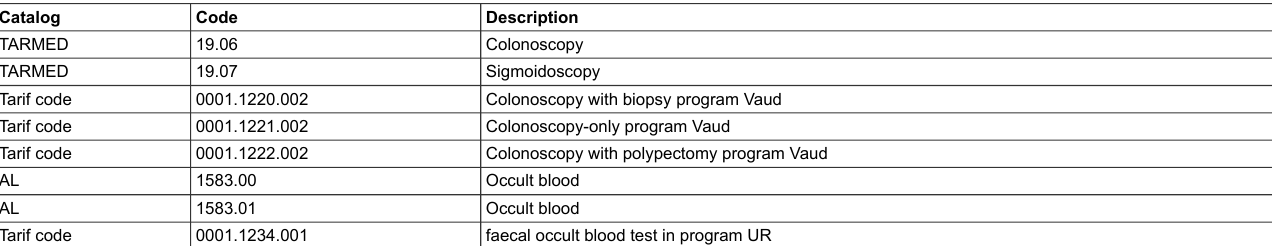
Table S1: Extracted colorectal cancer testing billing